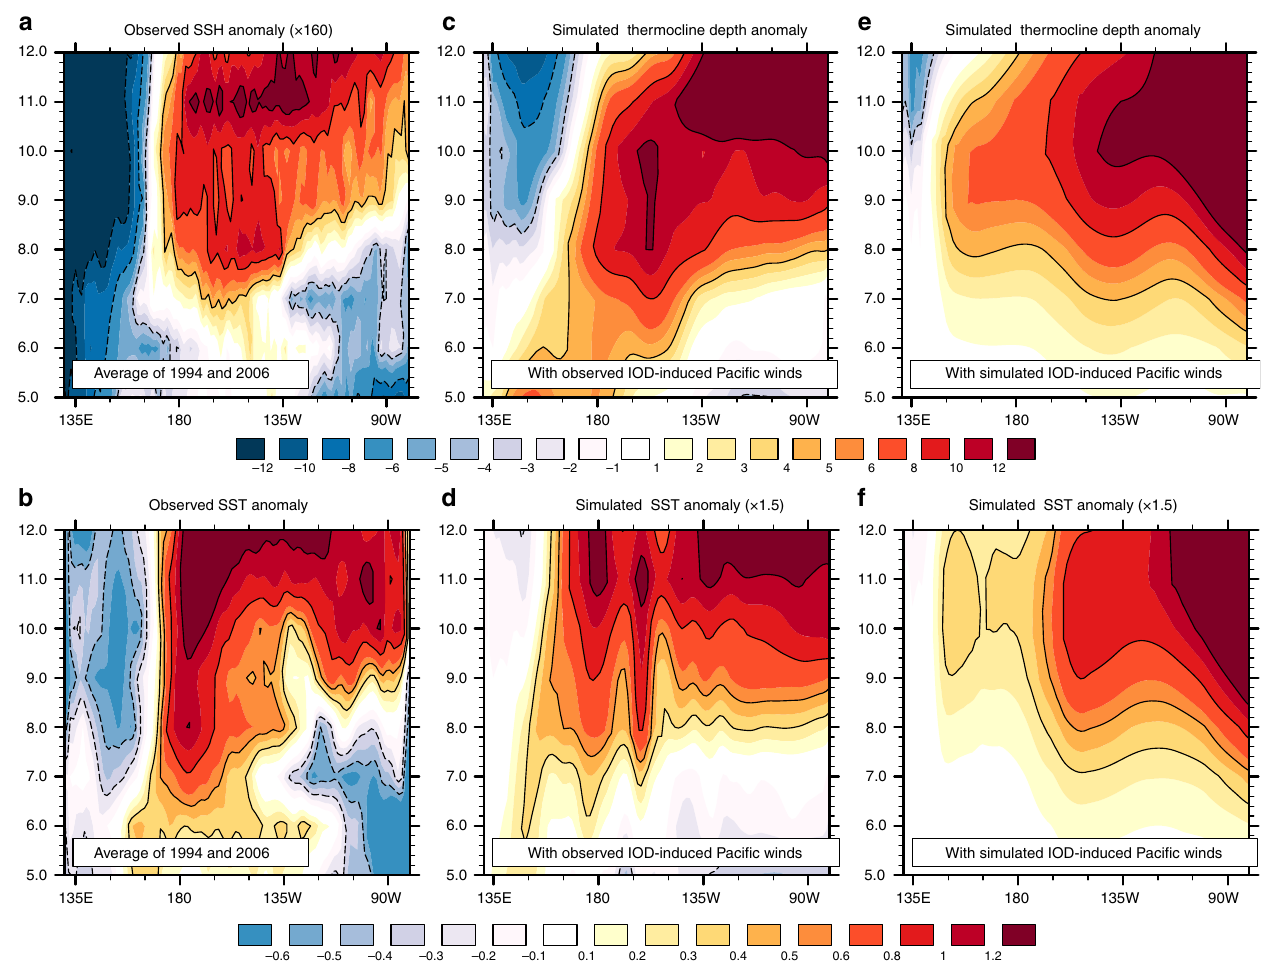
Fig. 8 The impact of IOD-induced western Paci fi c wind anomalies on the equatorial Paci fi c Ocean. Here, we conducted two set of ocean simulations to examine how the equatorial Paci fi c Ocean responded to IOD-induced western Paci fi c surface wind anomalies. In the fi rst set ( c , d ), the ocean model was driven by observed IOD-induced Paci fi c wind anomalies, which were estimated by compositing observed wind anomalies during 1994 and 2006. In a second set ( e , f ), the ocean model was driven by simulated IOD-induced surface wind anomalies, which were from an atmospheric model forced with diabatic heating anomalies over the tropical Indian Ocean (the diabatic heating anomalies were, in turn, estimated from composite OLR anomalies for 1982, 1994, 1997, and 2006). The ocean simulations may be compared with observed SSH ( a ) and SST ( b ) anomalies — both were composited from data during 1994 and 2006. The observed SSH anomalies were multiplied by 160 to facilitate comparison with the simulated thermocline anomalies ( c , e ): the factor of 160 is consistent with the regression coef fi cient between observed monthly sea level and the depth of the 20 °C isotherm in the equatorial Paci fi c 62 . Panels b , d , f show SST anomalies — the simulated SST anomalies in d , f were multiplied by 1.5, so that a single color bar can be used in the SST anomaly plots. All anomalies were averaged from 2.5°S to